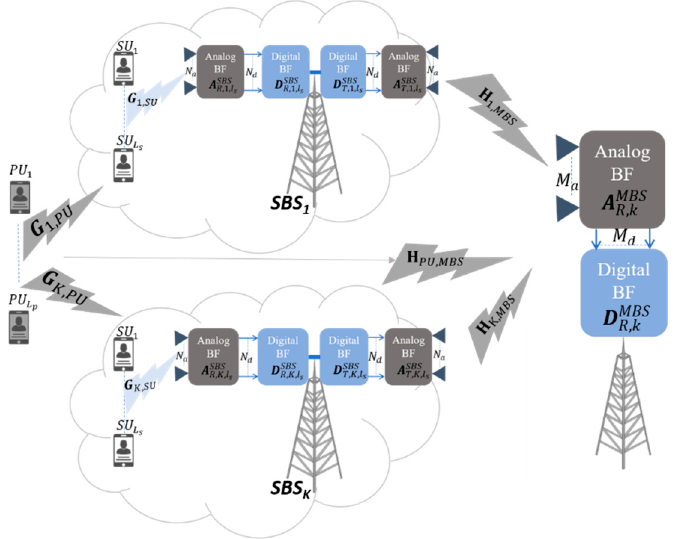
Figure 3. System model: hybrid beamforming-based HetNet with one macro-cell and K small-cells.